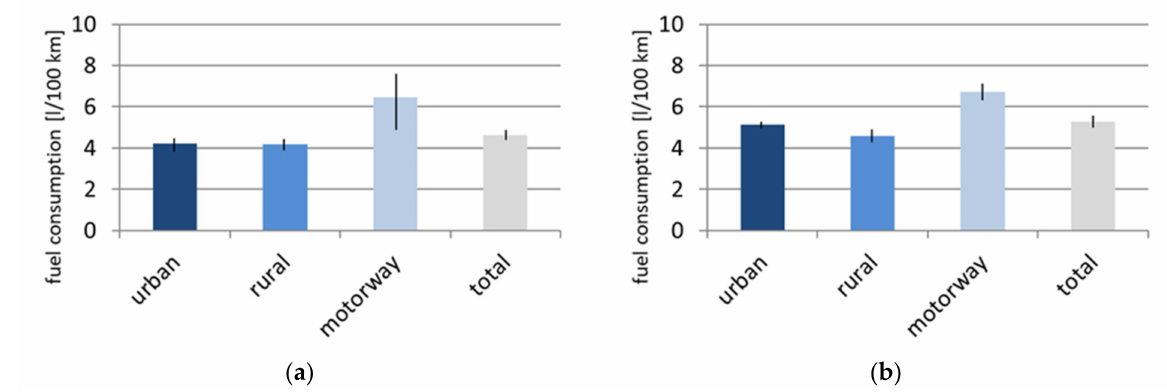
Figure 5. Seasonal influence on the real-world fuel consumption of the studied PHEV considering hybrid driving mode. ( a ) Summer time; ( b ) autumn